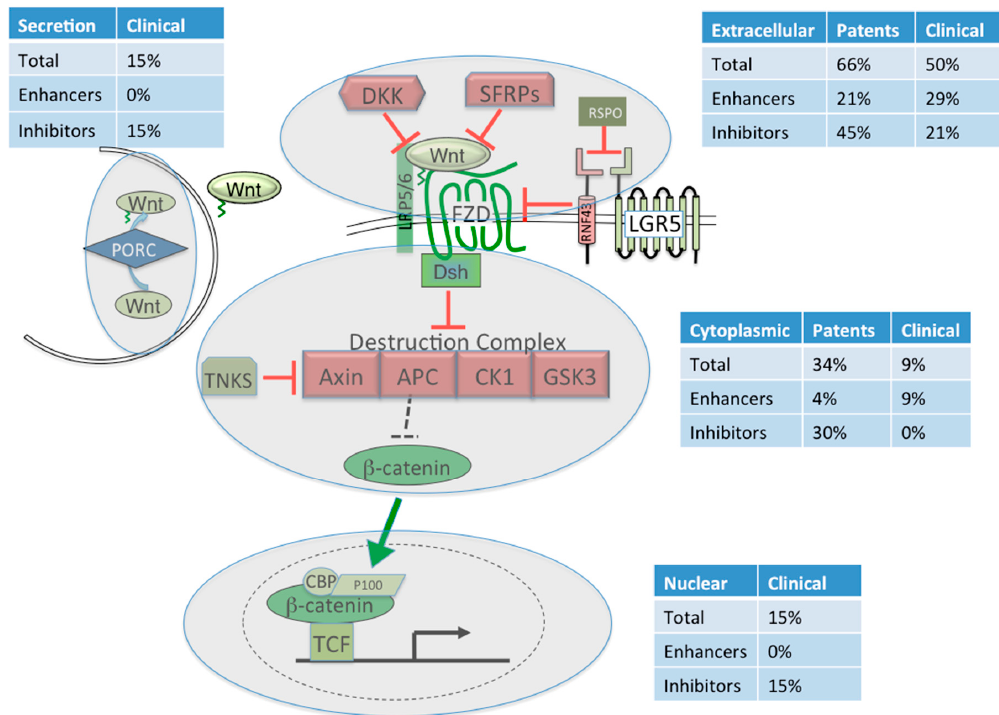
Figure 1. Patents and clinical trials involving the Wnt signaling pathway. Only the components of the Wnt pathway relevant to the patent or clinical trial searches are shown. Patents refer to novel compounds, peptides or proteins that modulate some aspect of the Wnt pathway. Red and green hued Wnt signaling components refer to the endogenous function of the protein as an inhibitor or activator of Wnt signaling, respectively. Grey transparent circles identify the space related to the percentage of patents or clinical trials occupying that space: Extracellular domain, cytoplasmic domain, nuclear domain or Wnt secretion domain. Percentages are relative to the total number of P/PA identified (103) or the number of clinical trials (34). See Table 2 for details on the enhancers and inhibitors in the different compartments. For the clinical trials, there are two unspecified targets and two that are targeting the epigenome, which together account for 11% of all clinical trials. Note that an absence of patent information for the Secretion and Nuclear domains does not mean there are no patents in these domains, just that they were not recovered from this